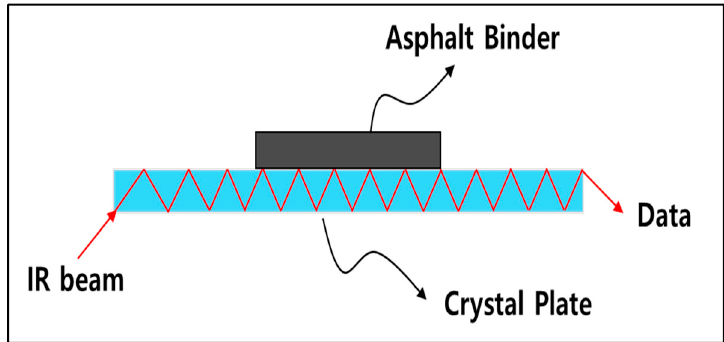
Figure 3. Principle of FTIR-ATR.